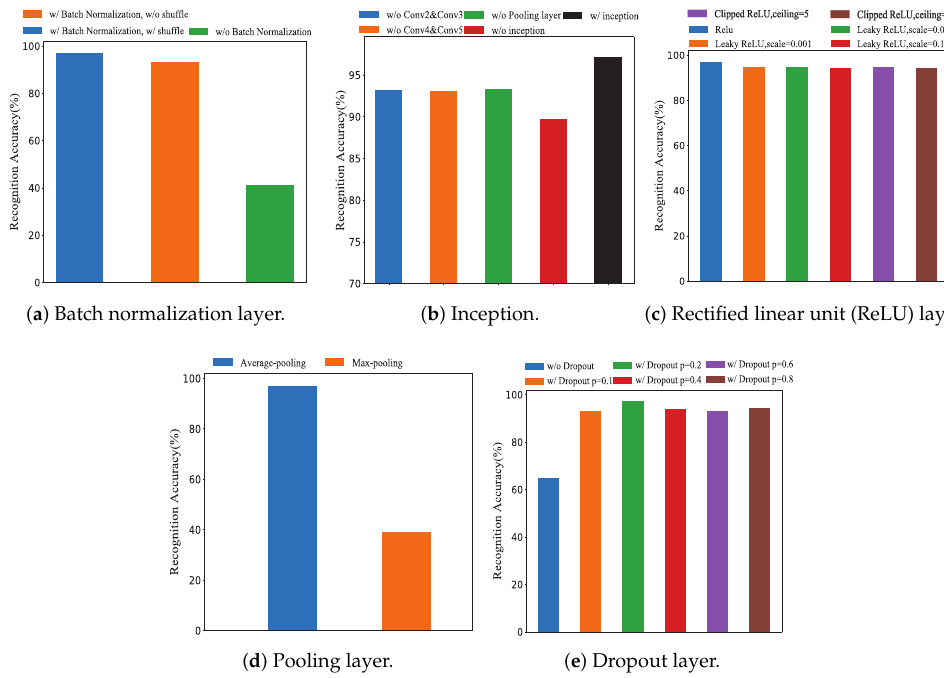
Figure 5. Impact of batch normalization layer, Inception, ReLU layer, pooling layer, and dropout layer on recognition accuracy using 10-fold